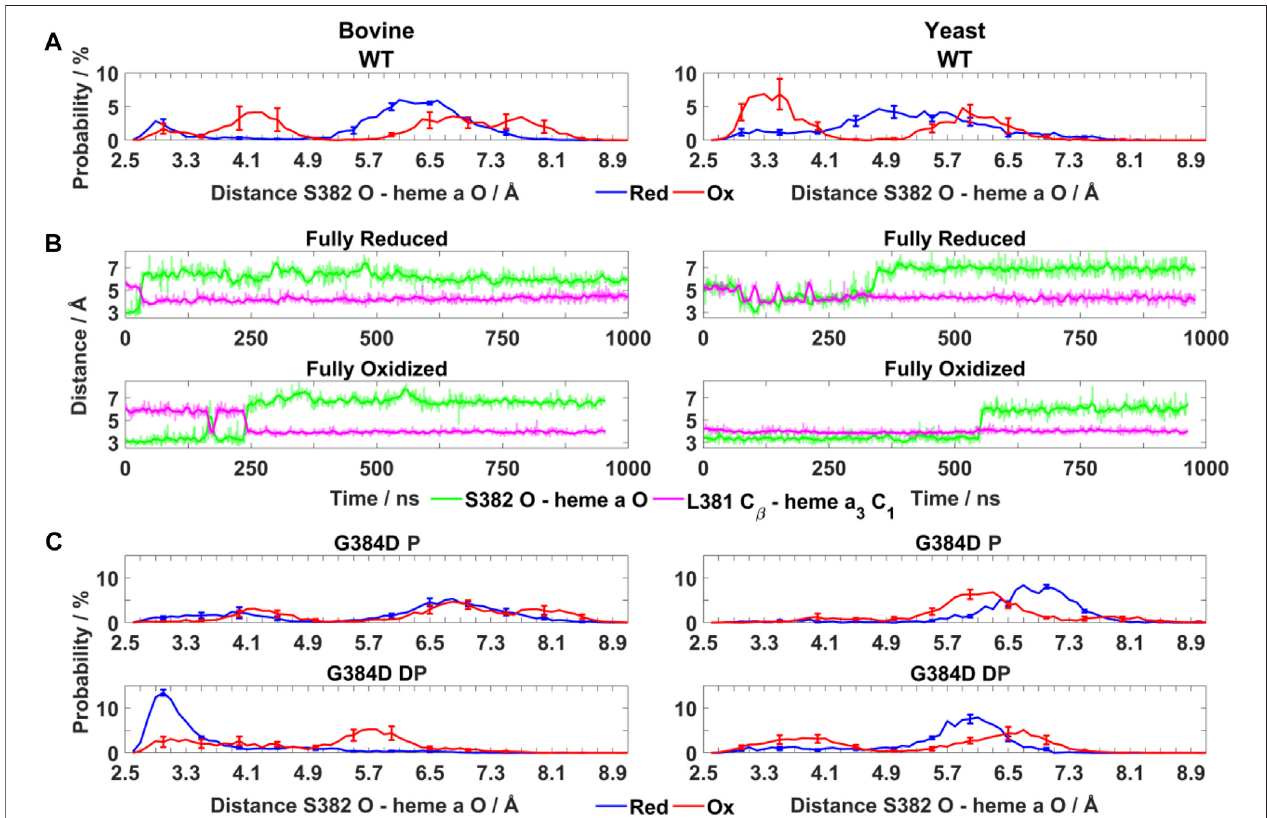
FIGURE 3 | Conformational dynamics of TMH X residues in WT and mutant bovine and yeast C c Os. (A) Probability distribution (%) of S382 hydroxyl (O atom) – heme a farnesyl hydroxyl (O atom) distance in bovine and yeast WT C c O in the fully reduced and oxidized states. (B) Typical time-series of the S382 hydroxyl – heme a farnesyl hydroxyl and L381 C β – heme a 3 C 1 distance inbovine (left) and yeast (right) WT C c Oin the fully reduced and oxidized states. (C) Probability distribution (%)of S382 hydroxyl – heme a farnesyl hydroxyl distance in G384D bovine (left) and yeast (right) C c Os with D384 (P - protonated/DP - deprotonated) in their fully reduced and oxidized states. The distributions are averaged over all simulation replicas and error bars correspond to standard